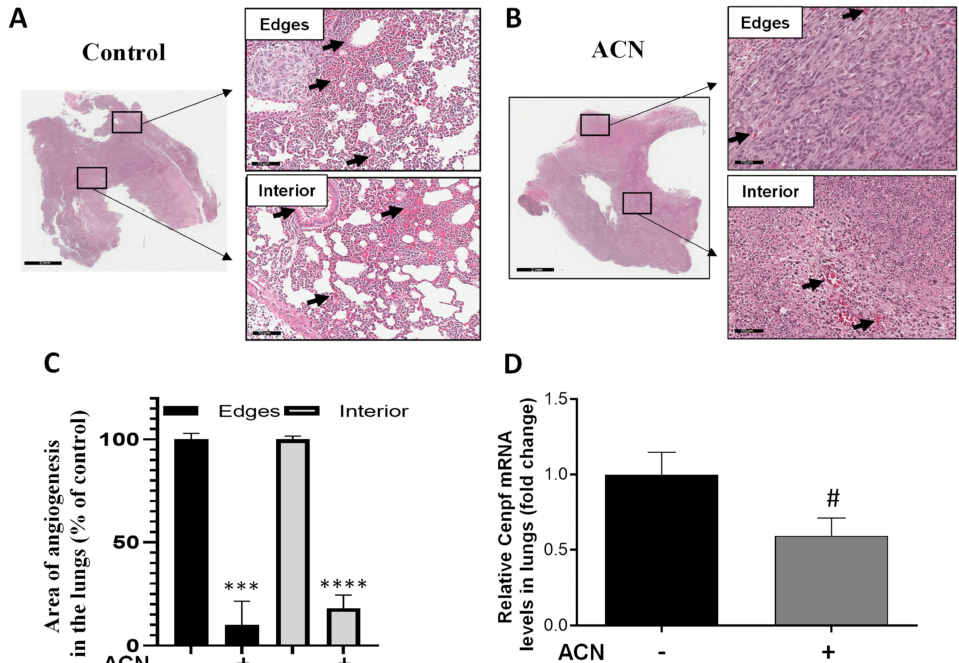
Figure 7. ACN decreased angiogenesis and Cenpf mRNA in lungs. Photomicrographs of lung tissues with arrows showing blood vessels in lungs of untreated control ( A ) and ACN-treated mice ( B ). Quantification of angiogenesis areas in edges and interior of lung tissues ( C ). Lung tissues were excised after 1 week ACN treatment (150 mg C3G/kg BW/day) as detailed in materials and methods. Photomicrographs of lung tissues (H&E, 30X) are representative of n ≥ 10 random areas per stained section (bar represents 70 µ m). Quantification of angiogenesis area was determined with ImageJ software. Data are mean ( n = 25 for untreated control and n = 12–14 for ACN) ± SEM. Cenpf mRNA levels in lung tissues ( D ). Lung tissues were ground with liquid nitrogen followed by mRNA extraction as detailed in materials and methods. Data from mRNA analysis are mean ( n = 4) ± SEM. The unpaired t test with Welch’s correction was used to determine significance (**** p < 0.0001, *** p < 0.001, # p =